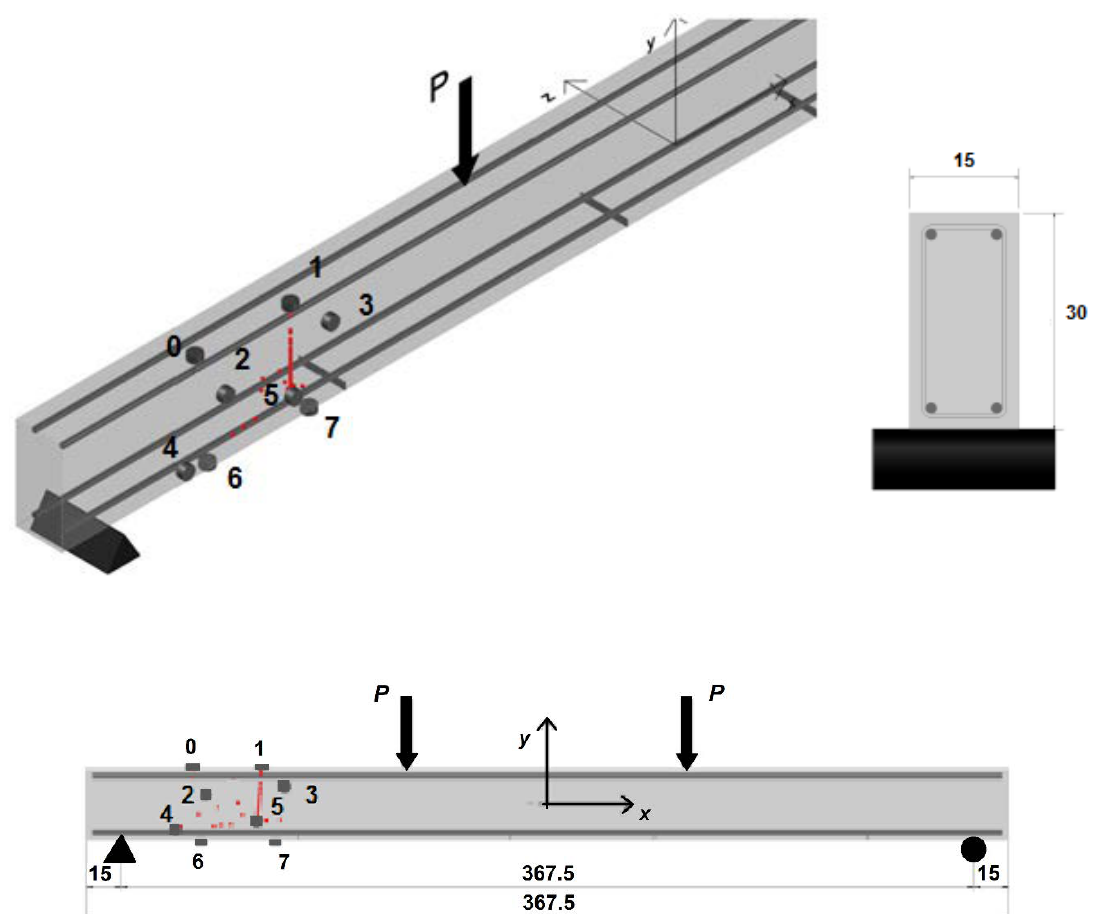
Figure 1. Specimen geometry and acoustic emission (AE) sensor locations. The eight AE sensors are numbered from 0 to 7. Dimensions are in cm.